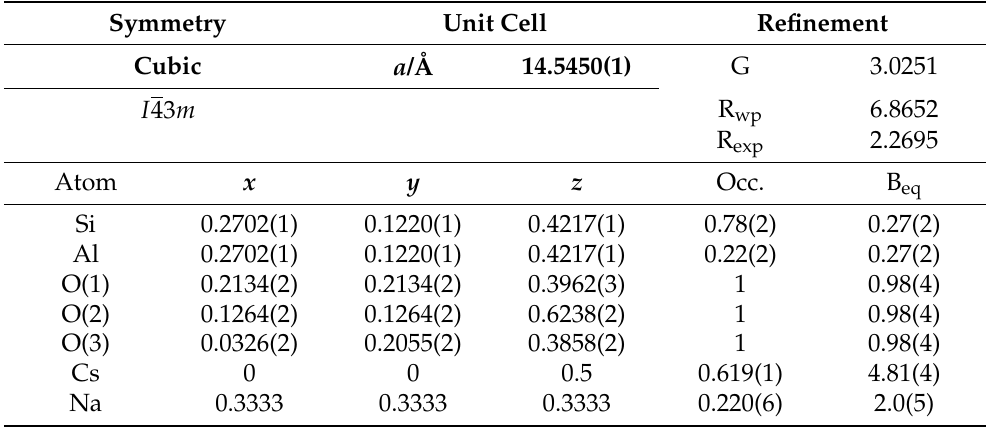
Table 3. Final refined unit cell parameters and crystallographic sites for the empty zeolite RHO sample. ‘Occ.’ refers to the fractional occupancy of the relevant crystallographic site. Error in parentheses.